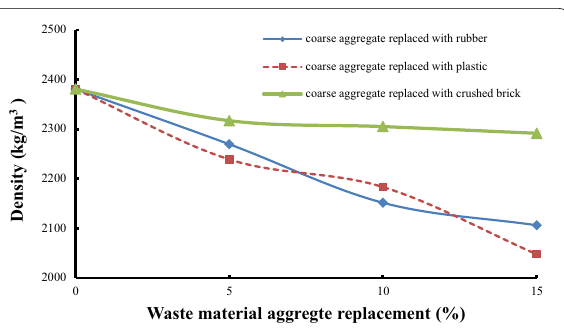
Fig. 5 Beam under testing machine.